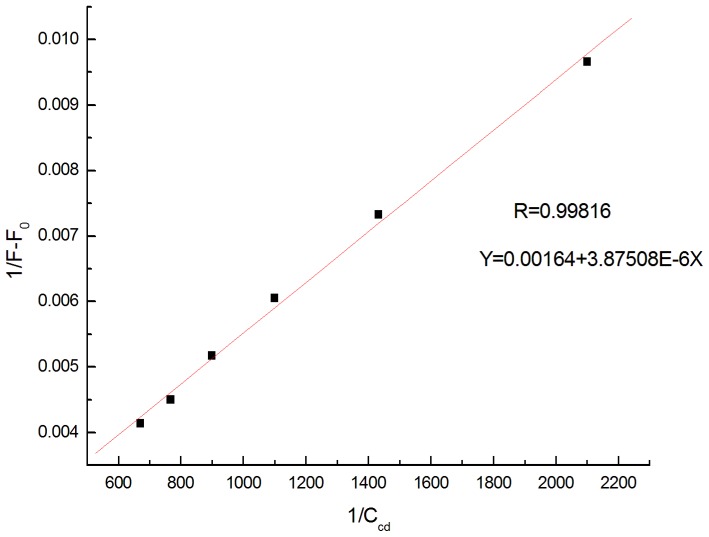
Plot of 1/(F−F0) versus 1/Cβ-CD.